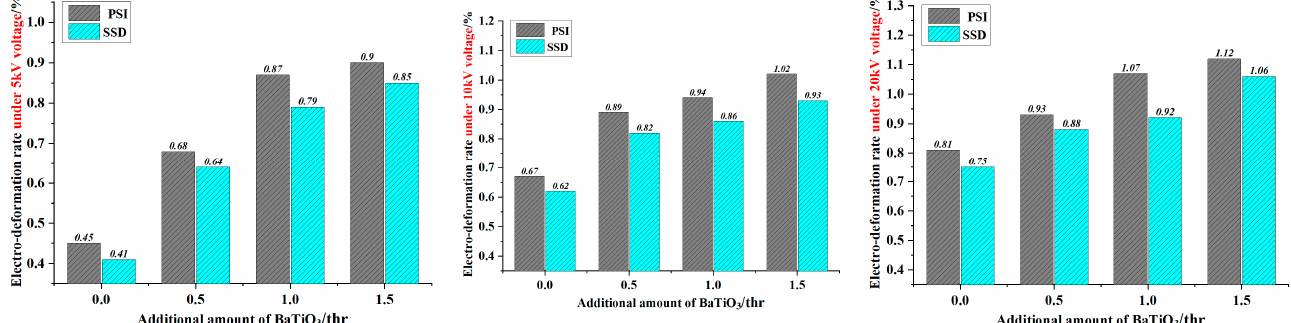
Figure 7. Diagram for electro deformability of the actuating unit under different coating methods.